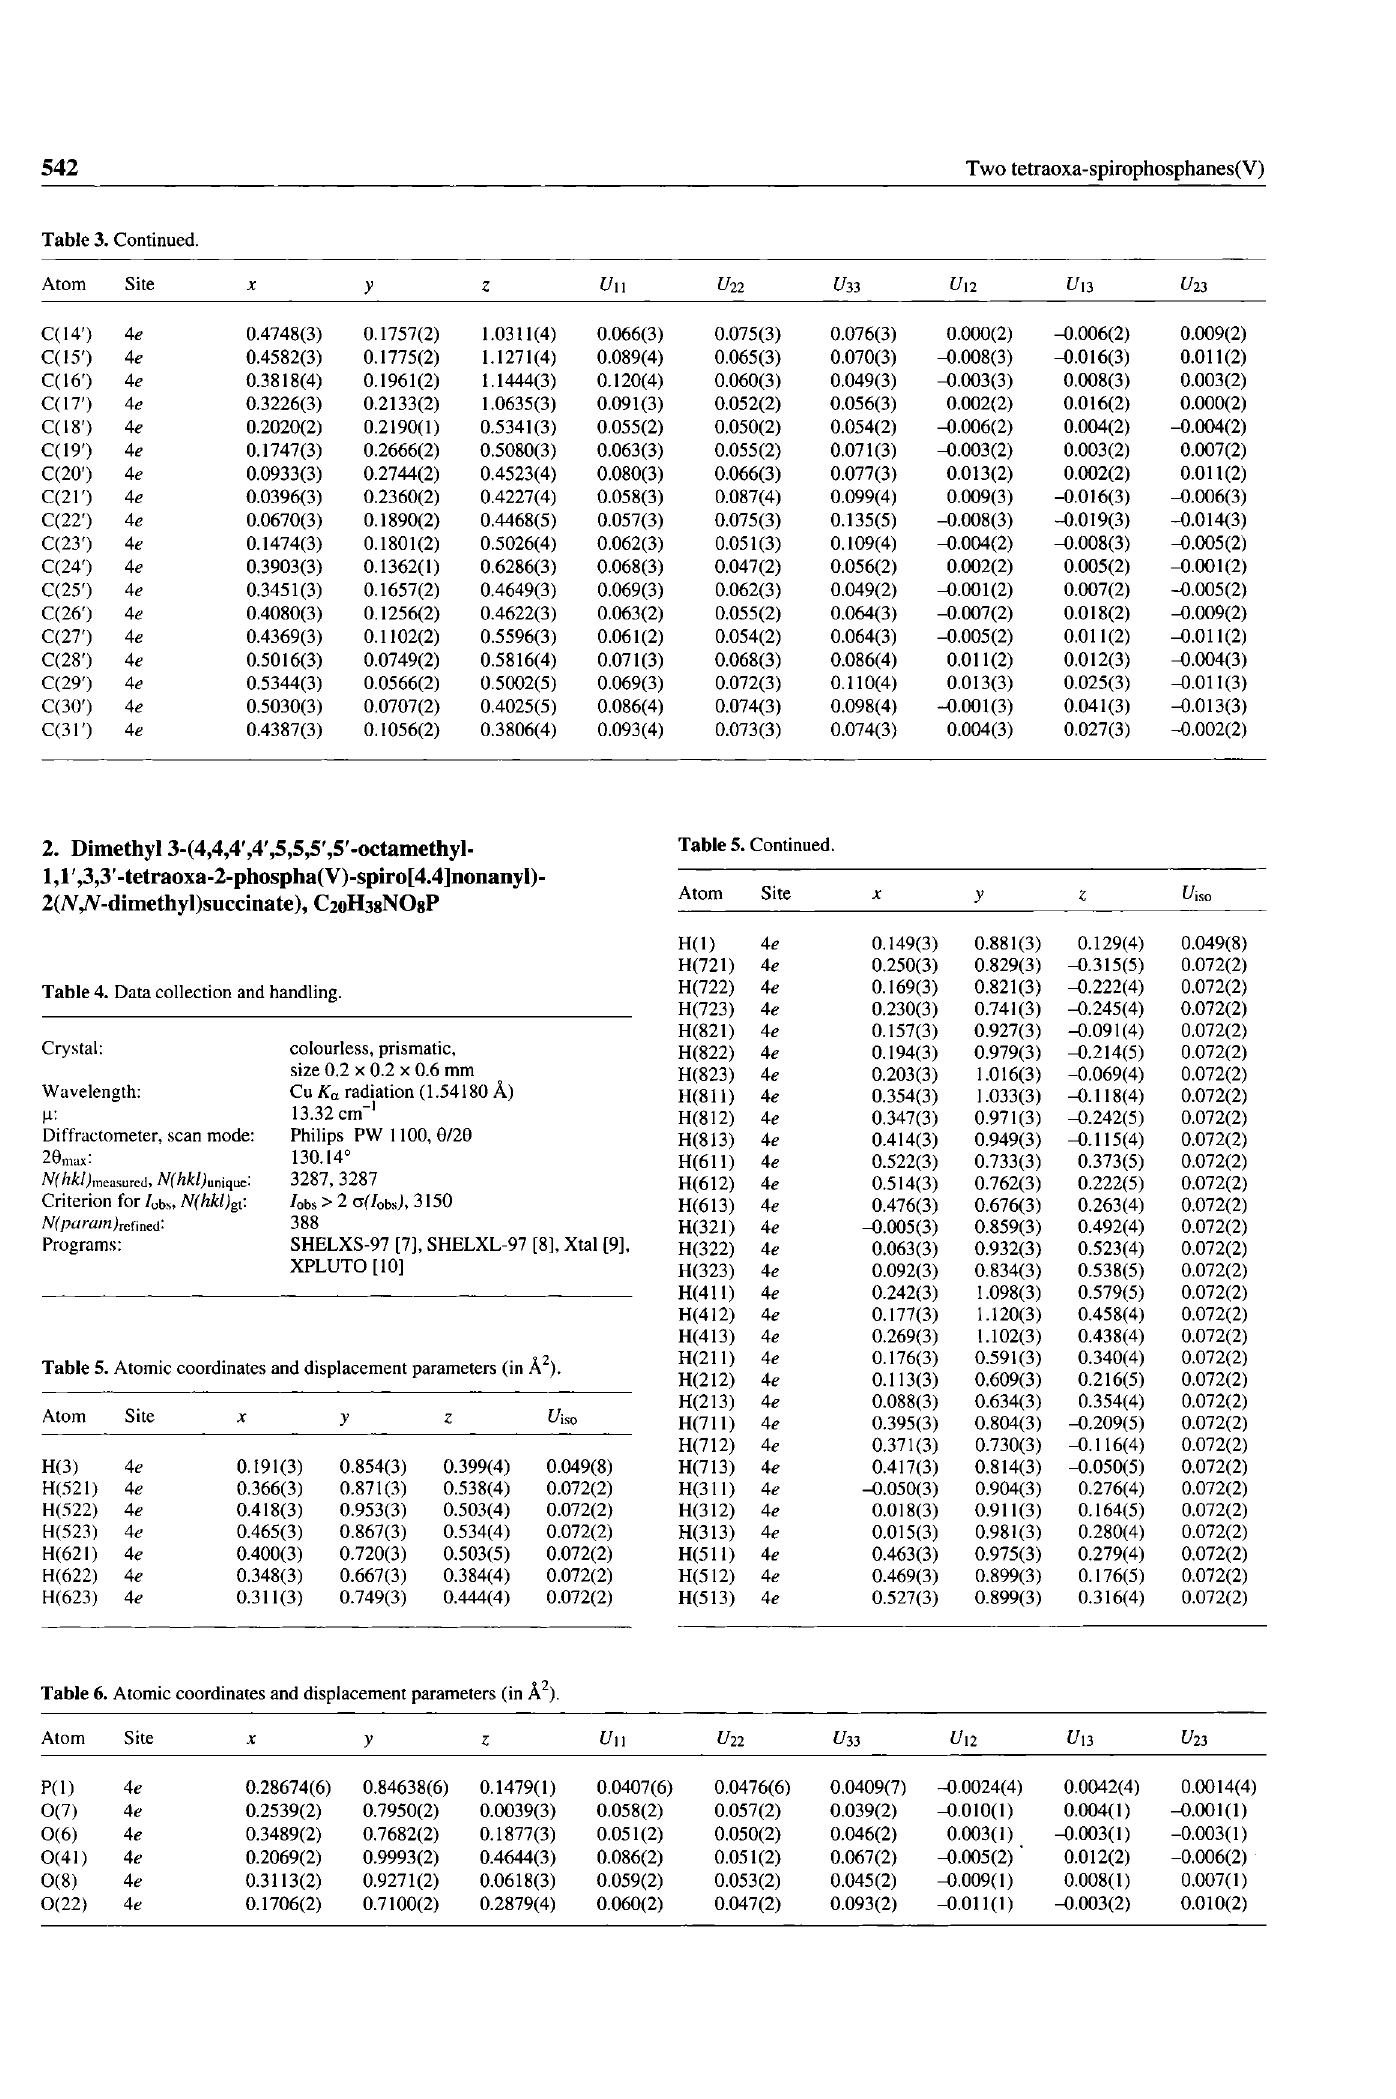
Table 6. Atomic coordinates and displacement parameters (in Â 2